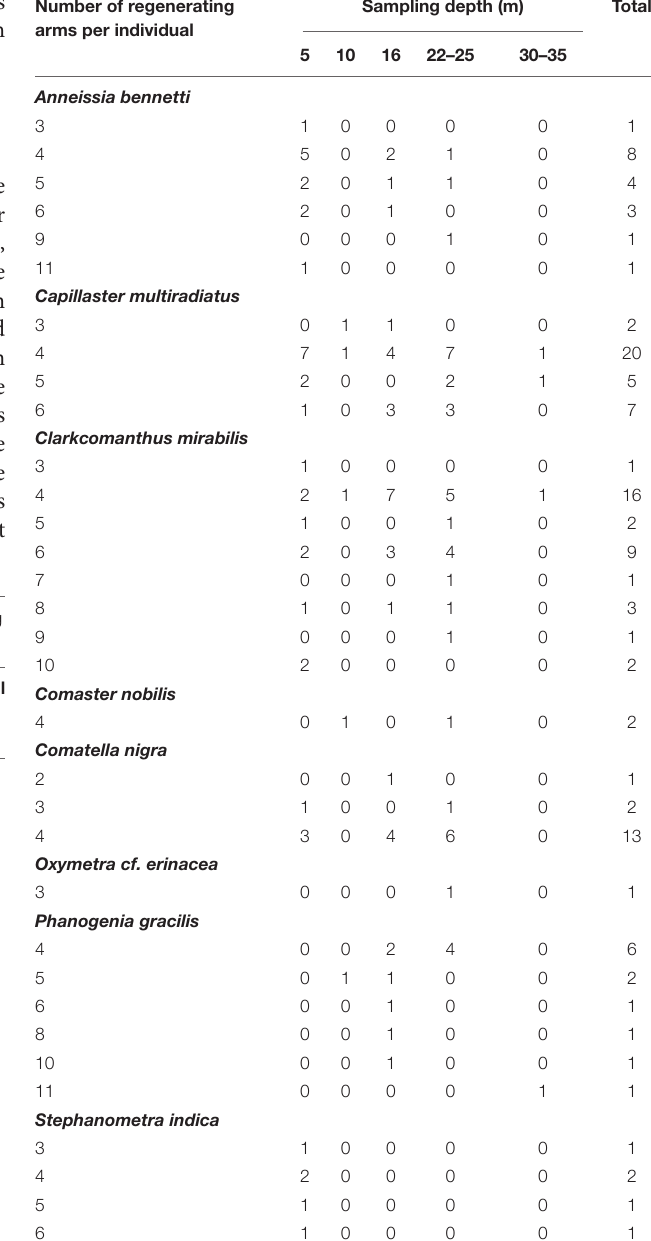
Species are organized by genus, in alphabetical order.